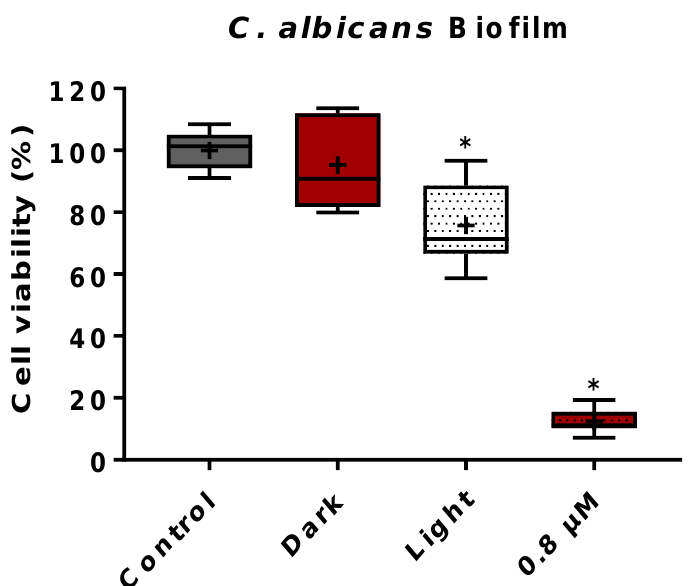
Figure 2. Box plot of cell viability of C. albicans ATCC 90028 biofilms assessed through MTT assay following treatment. Control: untreated biofilms; dark: biofilms incubated with 1.5 µ M of ZnP hexyl without irradiation; light: biofilms irradiated only (4.3 J/cm 2 ). aPDI was performed for biofilms incubated with 0.8 µ M of ZnP hexyl for 10 min followed by irradiation (4.3 J/cm 2 ). The results were expressed in relation to untreated biofilms. Differences between groups were analyzed by the Man–Whitney test and considered significant at p < 0.05. At least three independent experiments were performed. *: p < 0.05 compared to control.